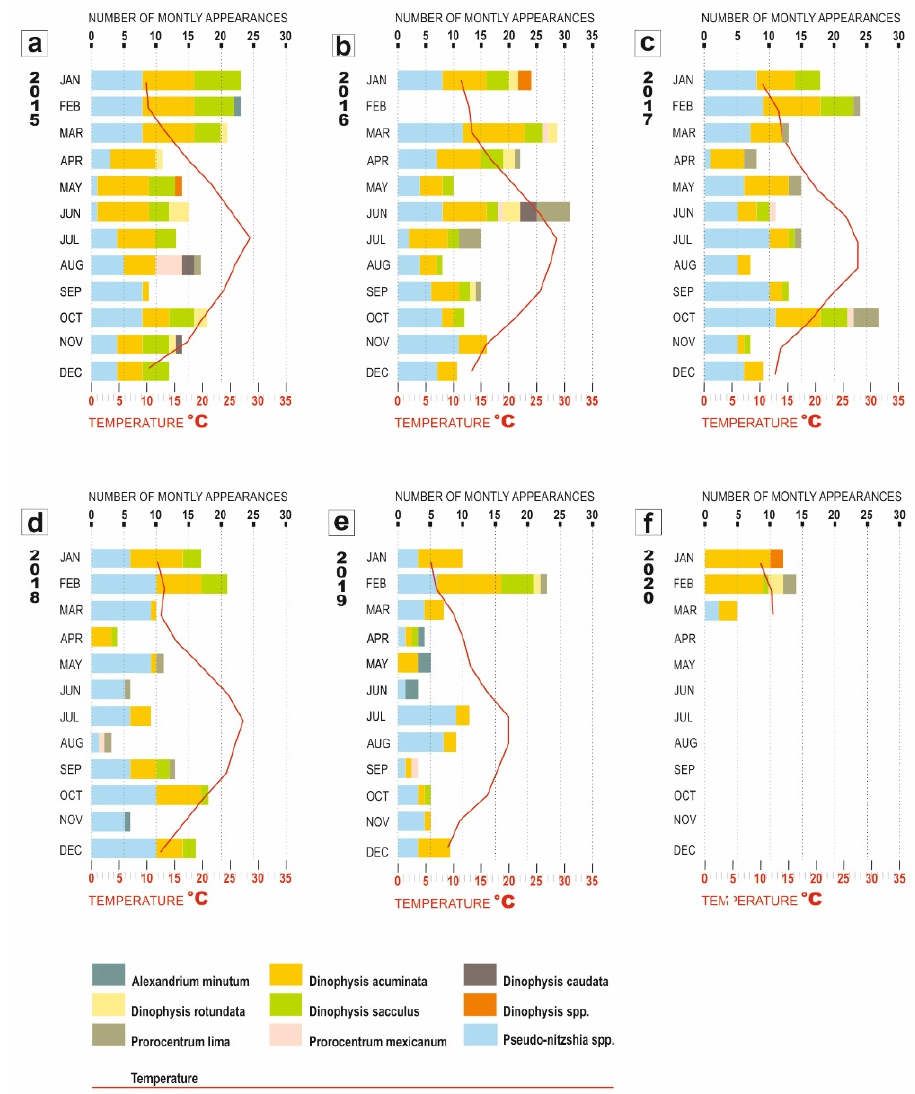
Figure 2. Temporal dynamics of the occurrence of harmful algal species in mollusk production areas